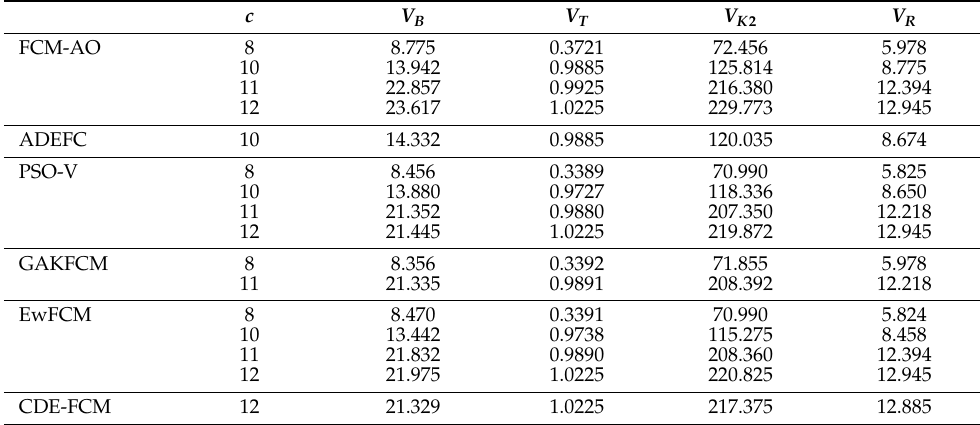
Table 8. Performance of algorithms on wine quality